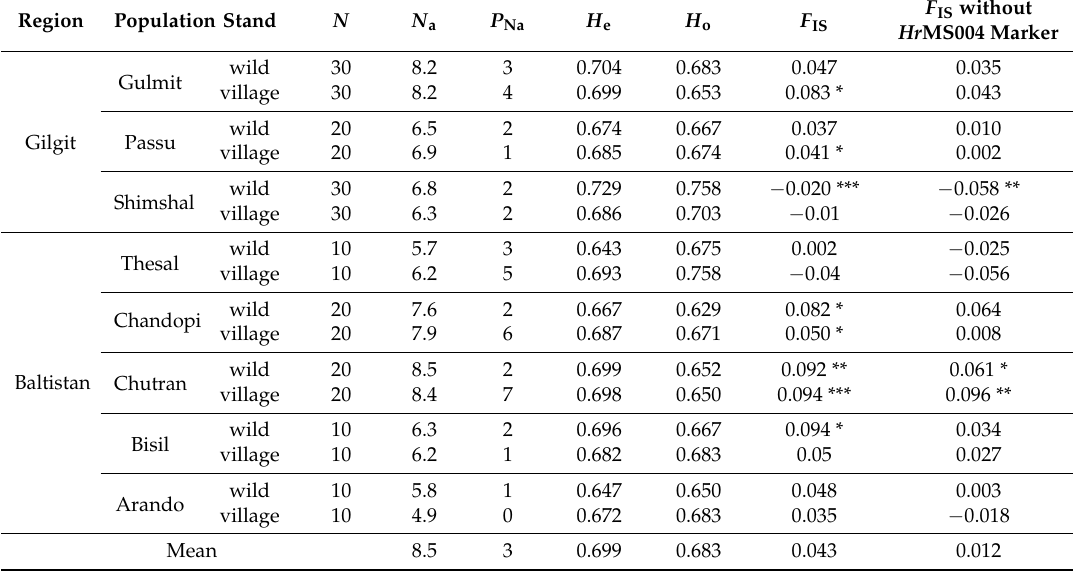
Table A1. Genetic diversity parameters of sea buckthorn populations among stands (wild and village) studied in the Gilgit and Baltistan regions, Pakistan.